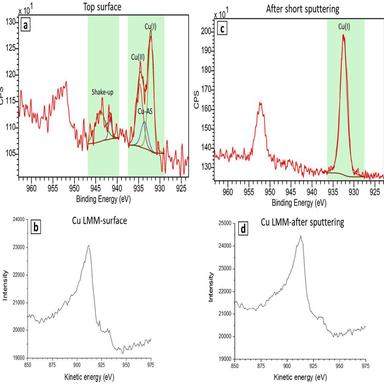
The high resolution spectra of Cu2p and Cu LMM peak on the top surface (a, b) and after a 5 s sputtering (5 s) by Ar+ ion (c, d).